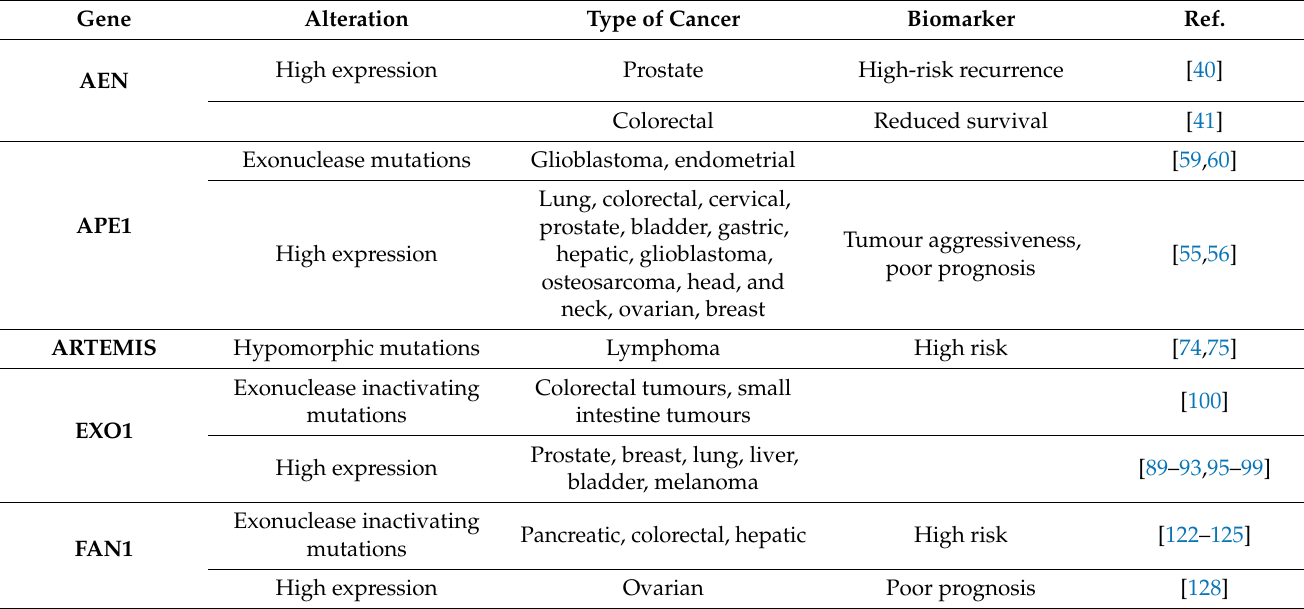
Table 1. Exonuclease alterations in